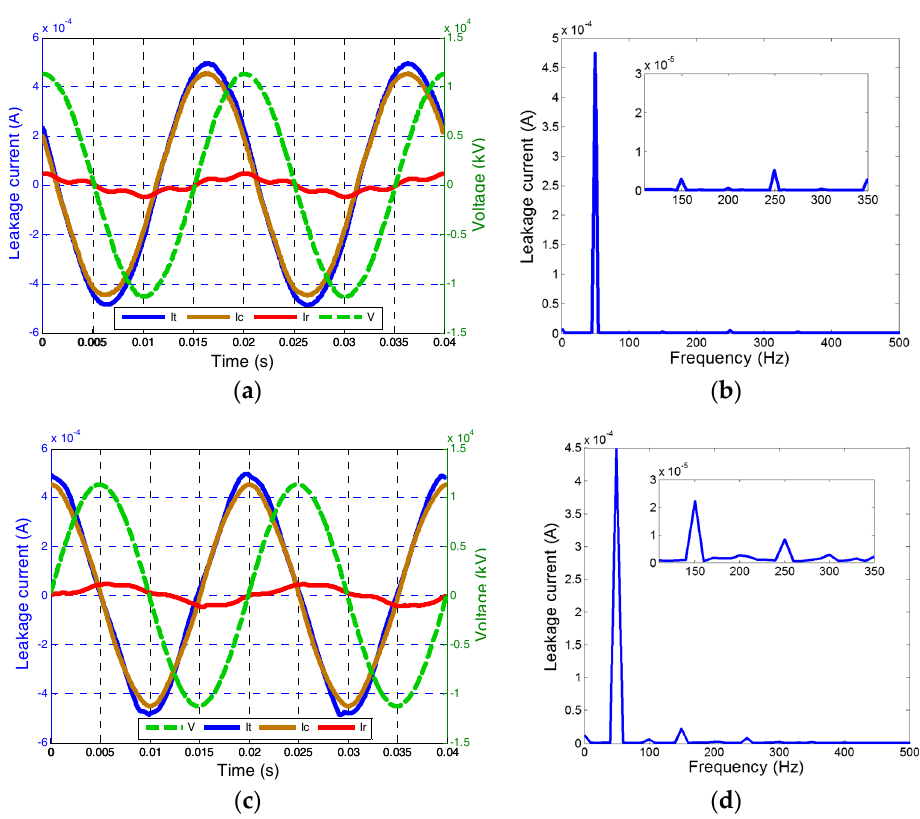
Figure 11. Leakage current waveforms and harmonic components at 8 kV rms applied voltage with heavily wet condition of surge arrester from the ( a ) measurement; ( b ) FEA model.